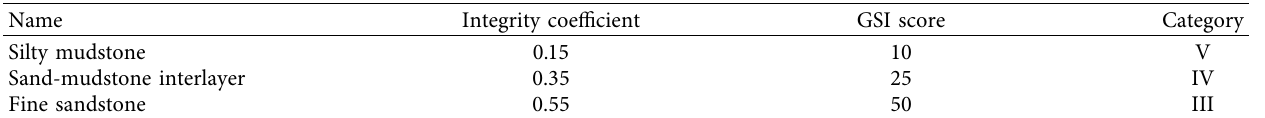
Figure 5: Mohr stress circle and envelope of each type of different surrounding rock. (a) Silty mudstone. (b) Sand-mudstone interlayer. (c) Fine sandstone. Table 5: Types and integrity coefficients of the surrounding rock in the fault